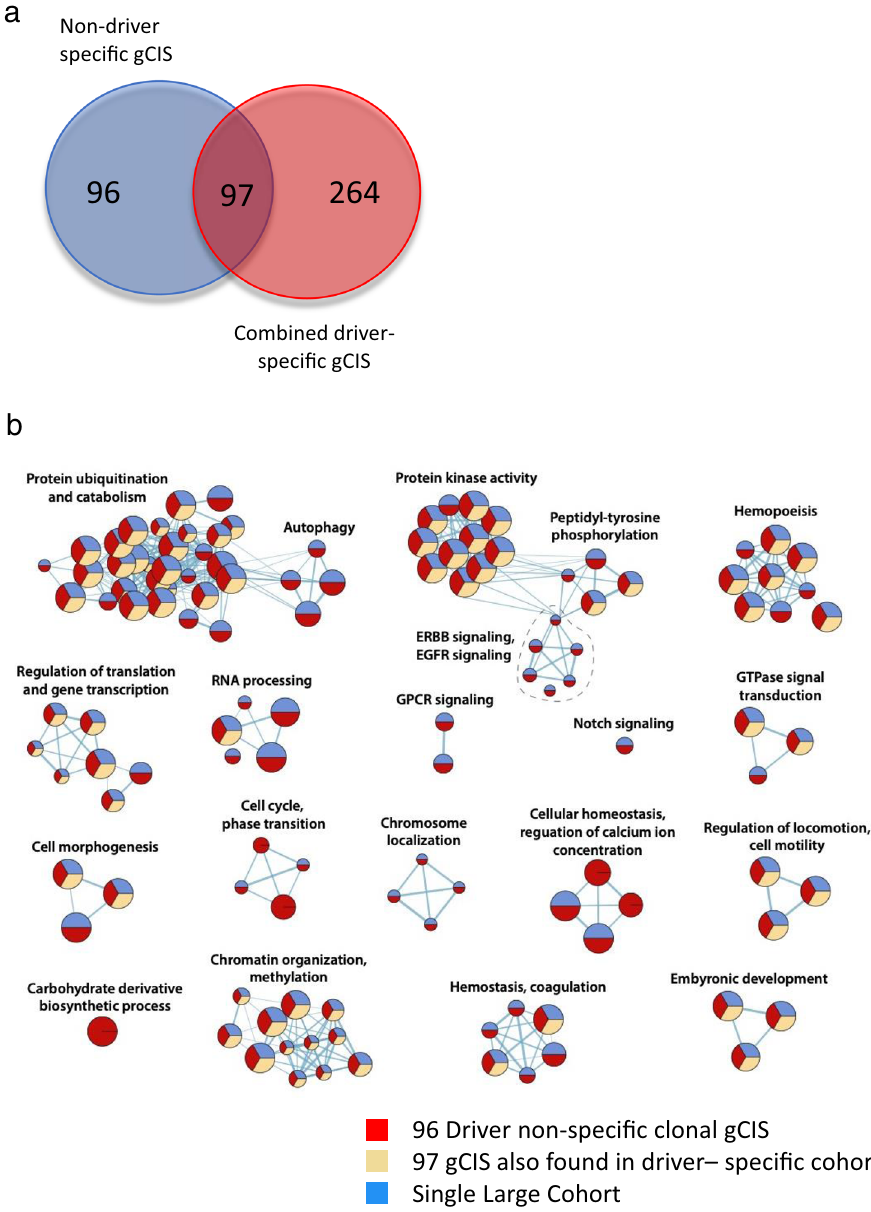
Fig. 3 SB insertion site analysis on one large cohort reveals distinct driver non-speci fi c gCIS. a Identi fi cation of 96 driver non-speci fi c gCIS in large cohort of tumors from Pik3ca E545K , Pik3ca H1047R , p53 R270H , Kras G12D , Stat3C , Notch1 ICD , and Elf3 GEMM model mice, These gCIS were not identi fi ed when each model was analyzed in isolation. b Pathways altered by SB mutagenesis in driver non-speci fi c large cohort screen — comparing gCIS that overlap with those found in driver-speci fi c cohort with those only identi fi ed in the large combined cohort (FDR corrected P -value < 0.05). Enrichment map shows enriched pathways and processes as nodes, while pathways with many shared genes are connected and cluster into subnetworks. Node colors indicate cohorts where gCIS events were enriched in the corresponding pathways. One-sided ranked hypergeometric tests were used and signi fi cant pathways visualized. p -value information for nodes are found in Supplementary Data